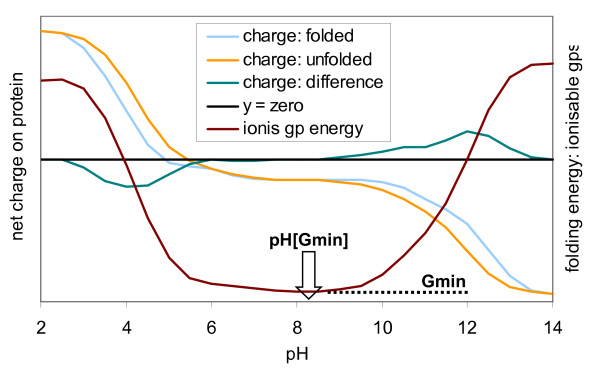
Schematic diagram of pH-dependent properties that can be predicted: titratable charge for folded and unfolded forms; the difference of these determines the pH-dependence of folding free energy (due to ionisable groups). Gmin is the minimum value of this energy, at pH [Gmin].